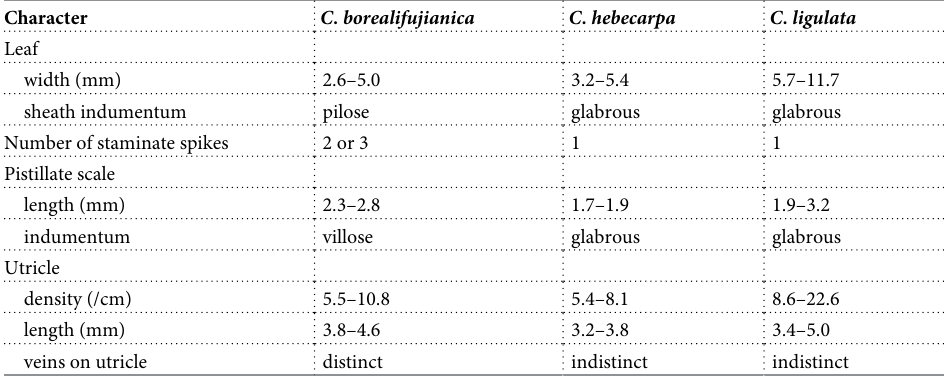
Table 4. Diagnostic characters distinguishing Carex borealifujianica from C . hebecarpa and C . ligulate